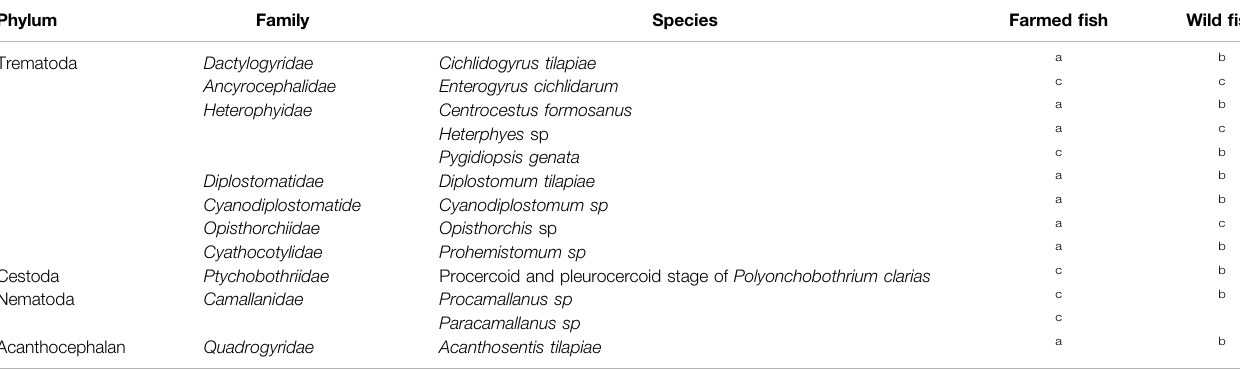
TABLE 5 | Parasites species isolated from farmed and wild fi sh, O. niloticus. Phylum